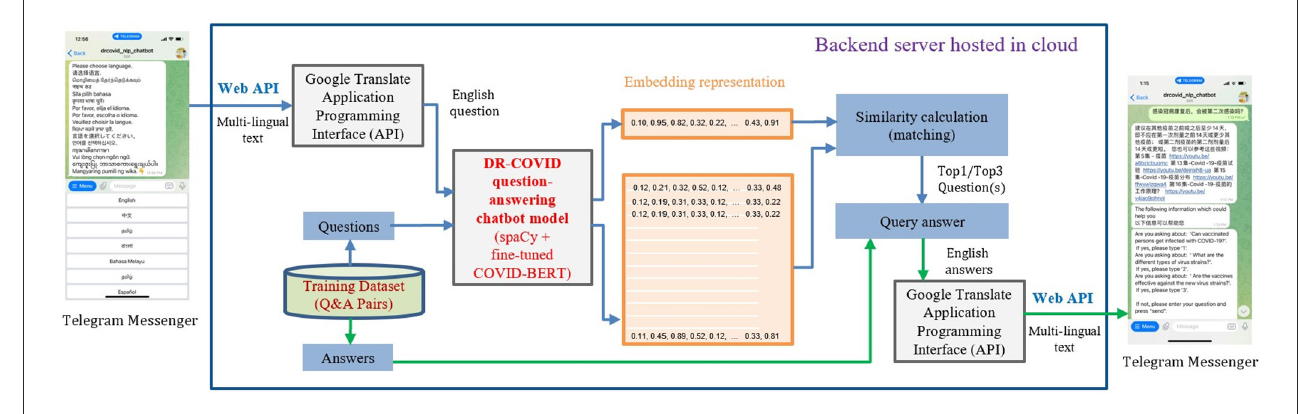
FIGURE1 Overview of DR-COVID Natural Language Processing (NLP) chatbot usage and architecture.